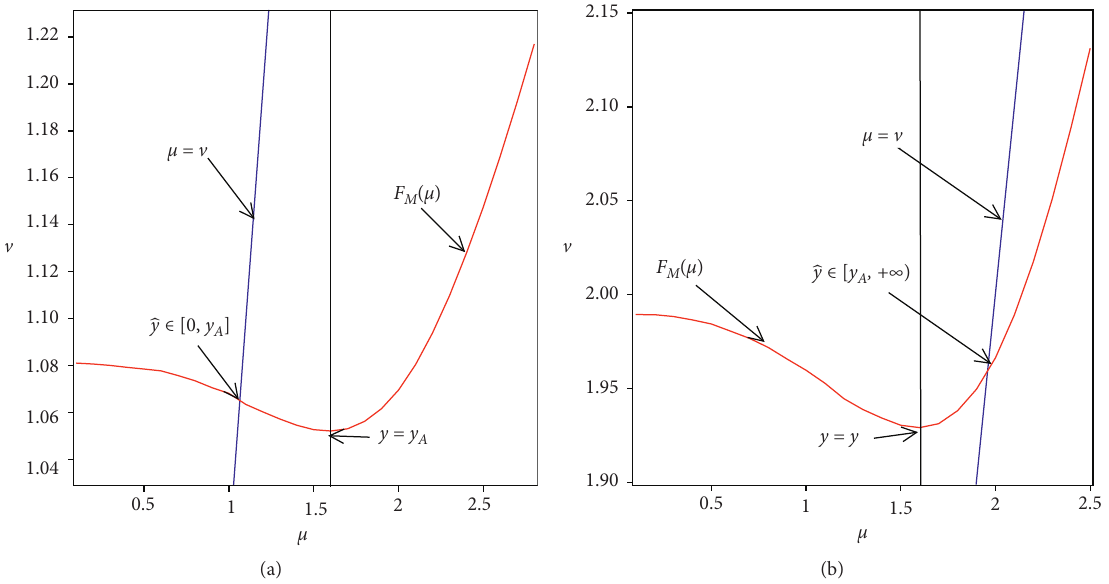
( μ ) and the parameters fixed as r � 2 . 5 , φ M